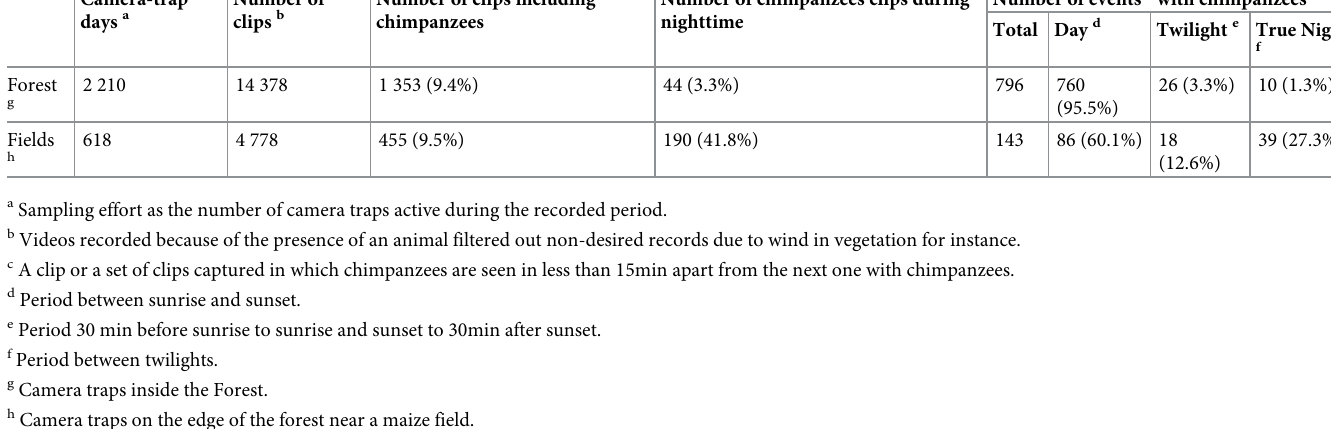
Table 1. Number of clips and events recorded in the forest and at the edge of the gardens during day and night. A total of 14 camera-traps were used over 2828 days from 03 January 2017 to 06 April 2018 in Sebitoli area, Kibale National Park, Uganda. Camera-trap days a